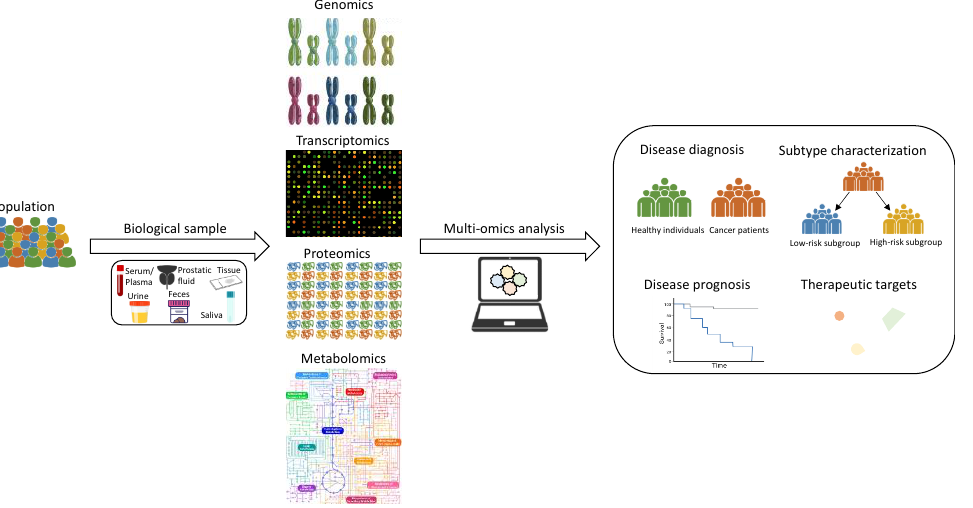
Figure 1. Graphical representation of different omics-based approaches and multi-omics analyses applied to the characterization of PCa-related metabolic alterations.